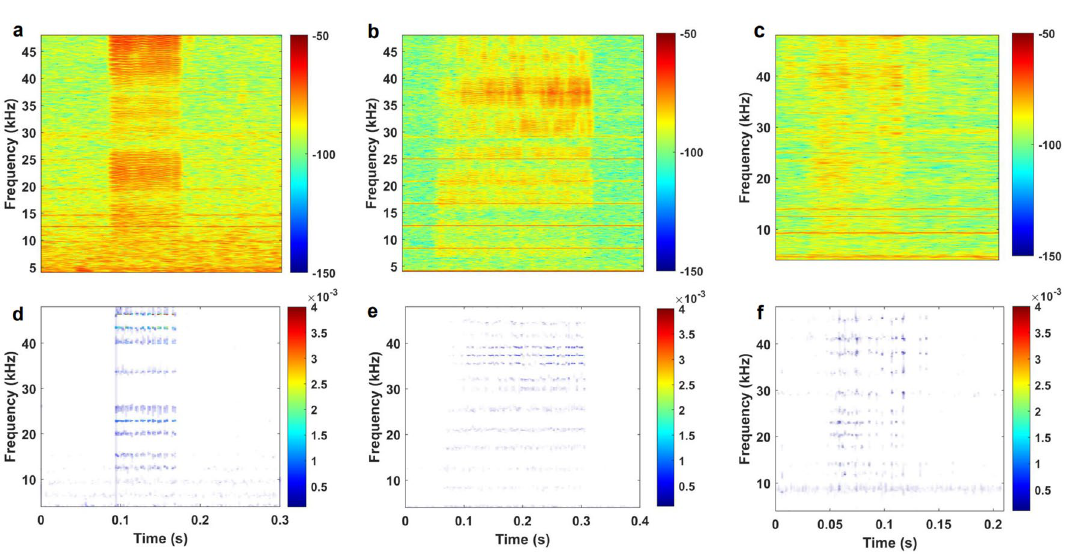
Figure 2. Spectrograms and VMD-grams of various data qualities. “Good” (a, d), “bad” (b, e), and “ugly” (c, f) data sample spectrograms ( a – c ) compared to their VMD-grams ( d – f ). “Good” means SNR > 6 dB and few electrical noise bands; “Bad” means SNR > 6 dB and more noise bands or background noise; “Ugly” means SNR < 6 dB. Energy bars are in jet color scale where redder is more energy and bluer is less